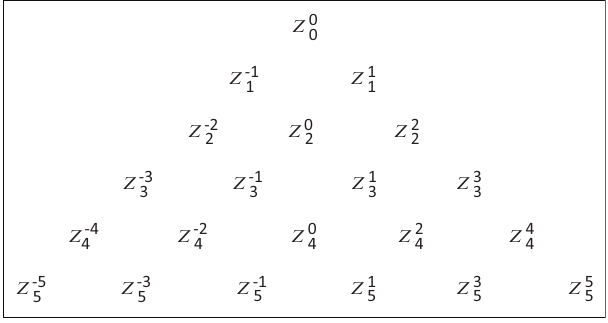
FIGURE 1: The function pyramid presenting the Zernike polynomials from the zero ( n = 0) to fifth ( n = 5) order.